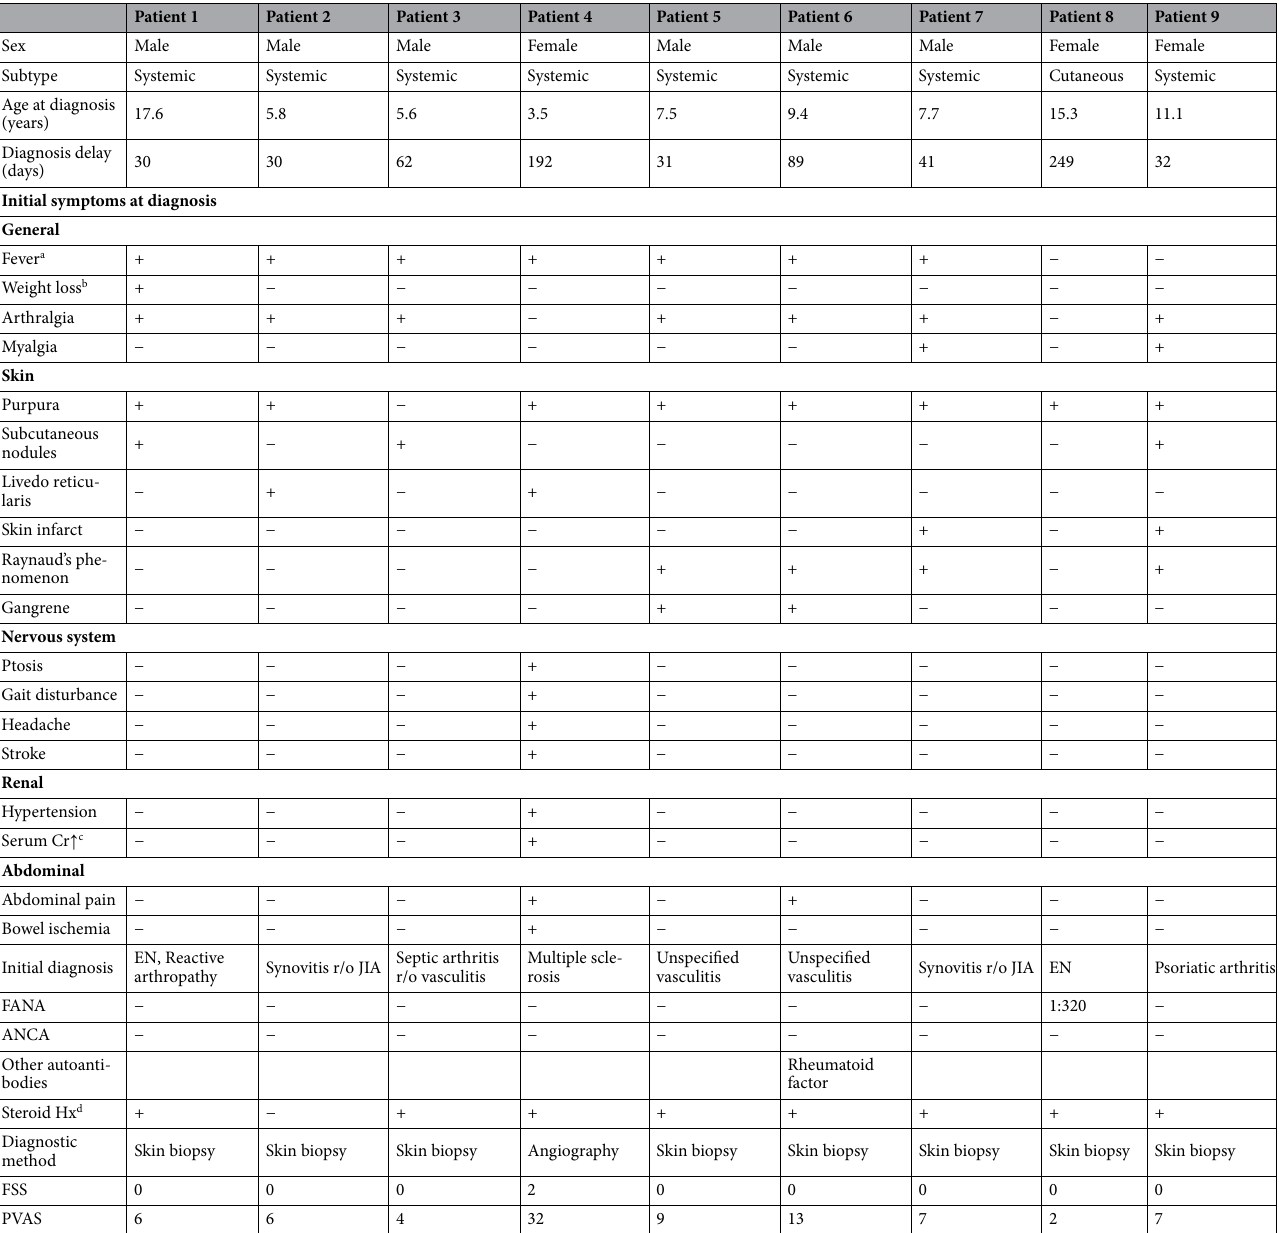
Table 1. Clinical characteristics at diagnosis. EN: erythema nodosum; JIA: juvenile idiopathic arthritis; FANA: antinuclear antibody; ANCA: anti-neutrophil cytoplasmic antibody; FFS: Five-Factor Score; PVAS: